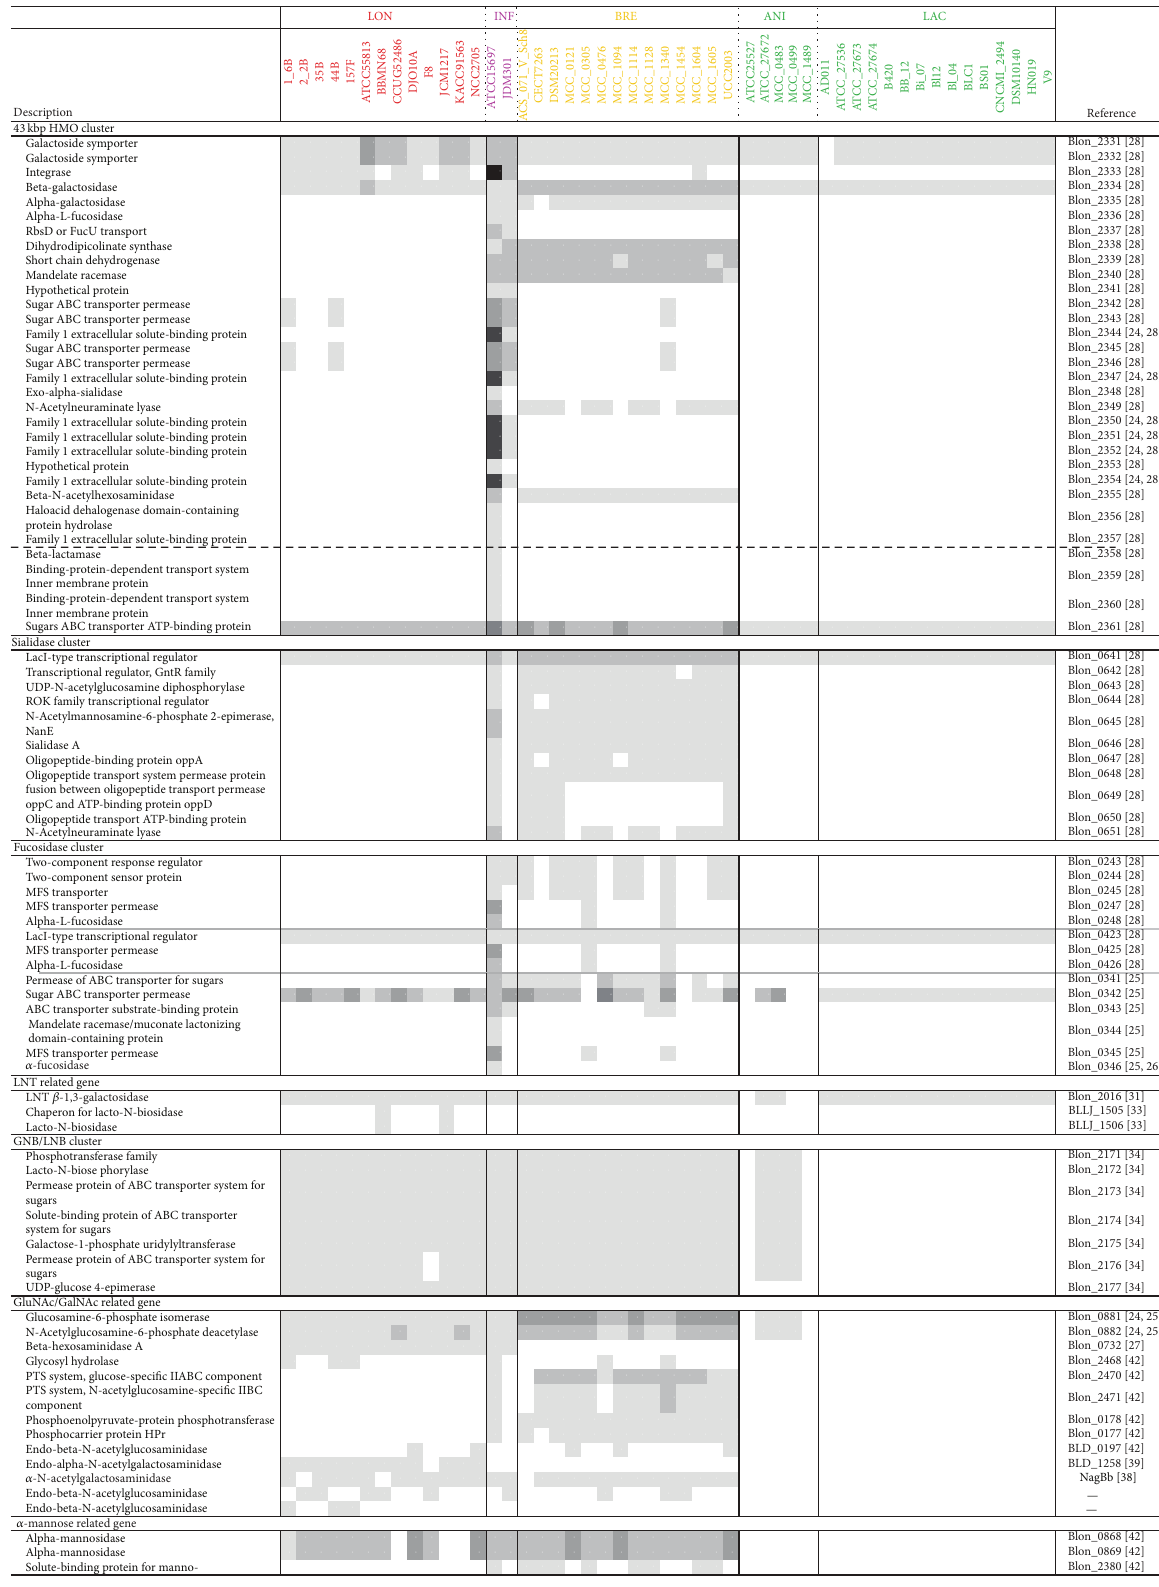
Endo-beta-N-acetylglucosaminidase